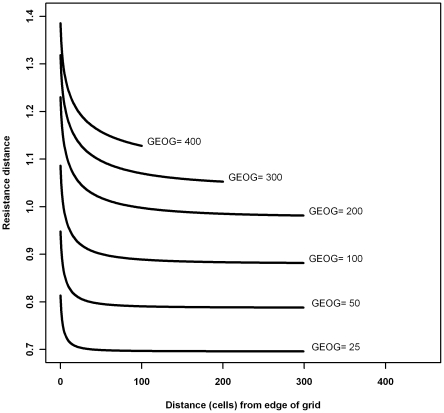
Pairwise resistance as a function of distance from the point nearest to the edge of the grid.Circuitscape isolation by resistance calculated over a linear distance in a circular grid of uniform resistance, 1 unit per cell, cell size 1 unit, and grid radius 500 cells. Each curve represents a different pairwise geographic distance. As a pairwise distance increases, so does the distance from the edge of the grid at which an edge effect of increased resistance distance is apparent. Where the edge of the grid represents an artificial barrier the resistance distance will be overestimated.